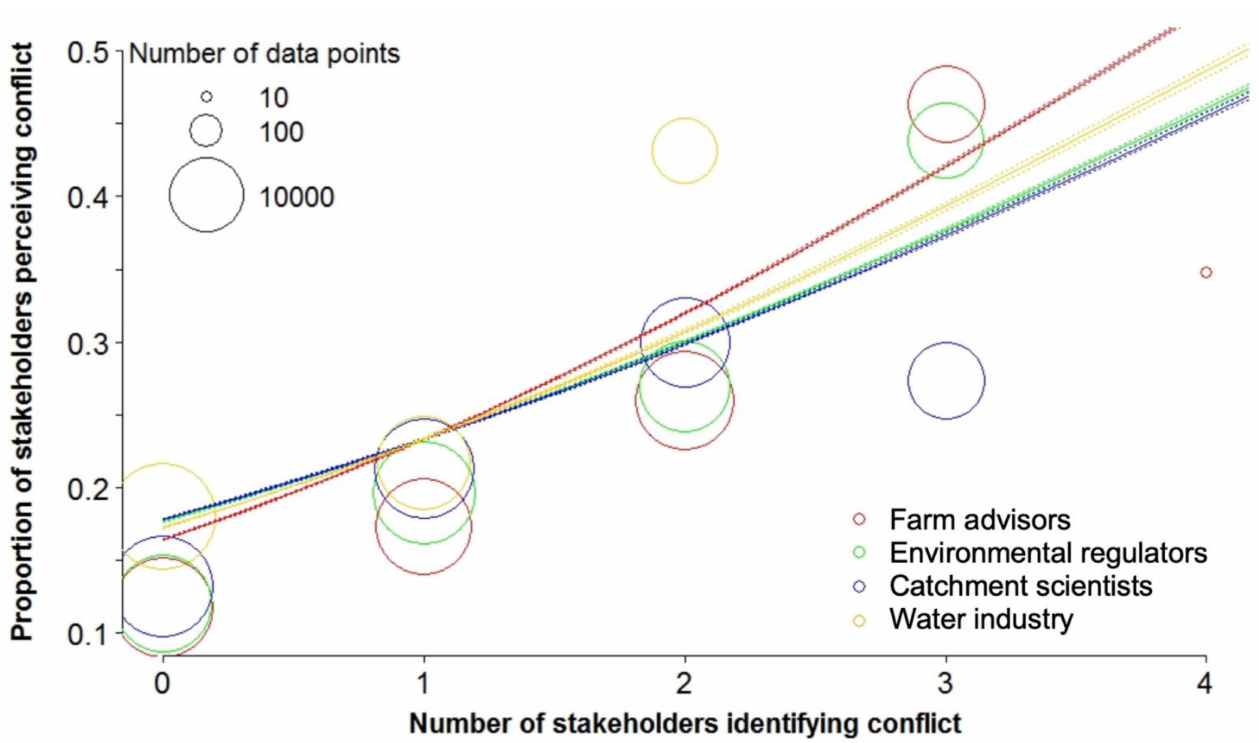
Figure 6. General linear model predictions of the relationship between the number of stakehold- ers from each group and the proportion of stakeholders perceiving conflict across the catchment (modelling for the South Esk catchment and the broadleaf forest land cover type as they were the first factors, and catchment type and land cover were not considered in this model). Data points are displayed using a logarithmic bubble graph to portray the large number of 10,000 m 2 rasters used for the